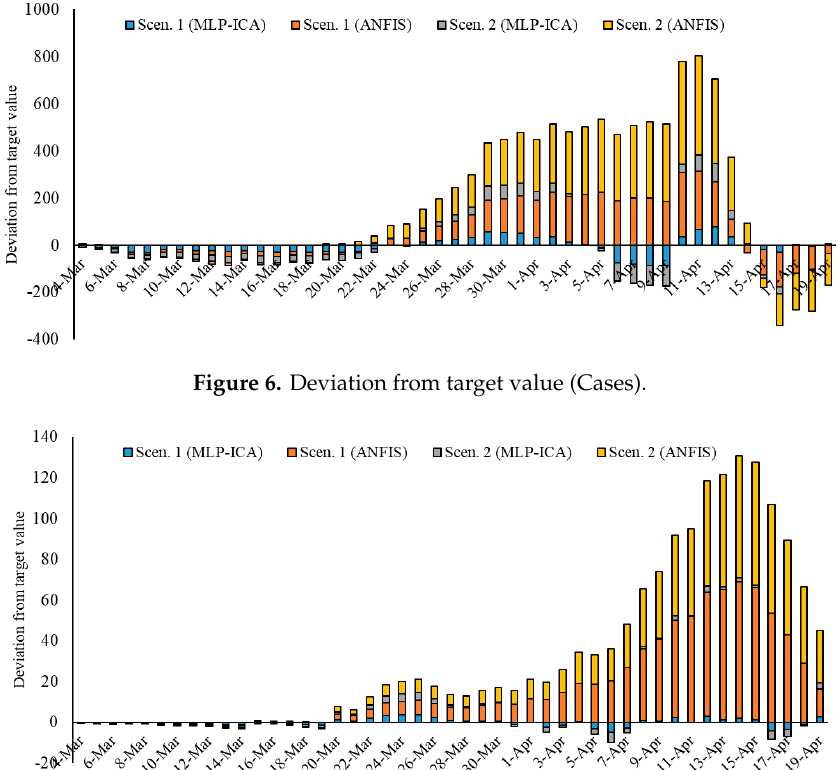
Figure 7. Deviation from target value (mortality rate).